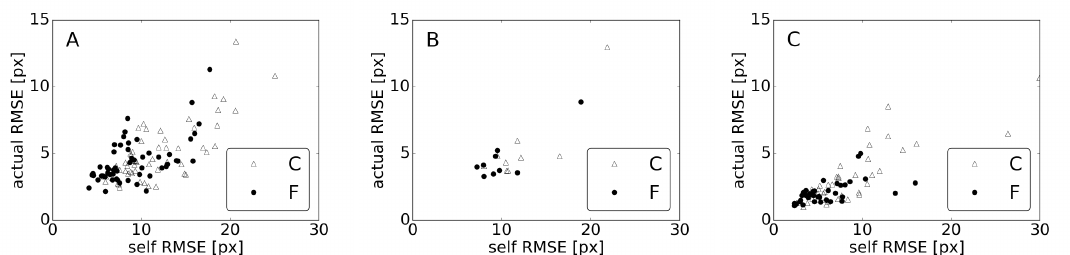
Figure 9. Actual RMSE—RMS distance from manual to automatic shorelines—versus self-computed error, in pixels, for all planviews of beaches ( A ) CFA1, ( B ) BCN1 and ( C ) BCN3, both for the combined (empty triangles) and the filtered (filled circles) shorelines.